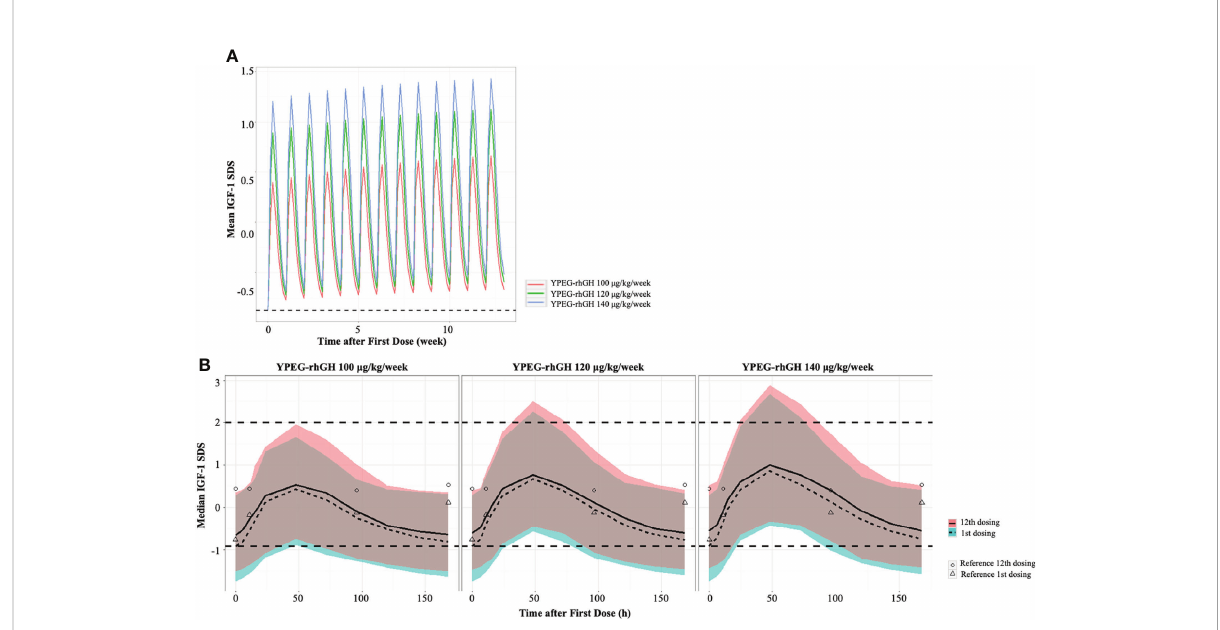
FIGURE 3 Model derived pro fi le of IGF-1 SDS. (A) , the model-derived pattern of IGF-1 SDS during dose interval of YPEG-rhGH. (B) , model-derived PK/PD pro fi les of IGF-1 SDS. The green and pink area indicated the 95% con fi dent interval of IGF-1 SDS after the fi rst dose and last dose of YPEG- rhGH. The hollow triangles and dots indicated the mean IGF-1 SDS after the fi rst and last dosing of daily rhGH respectively.